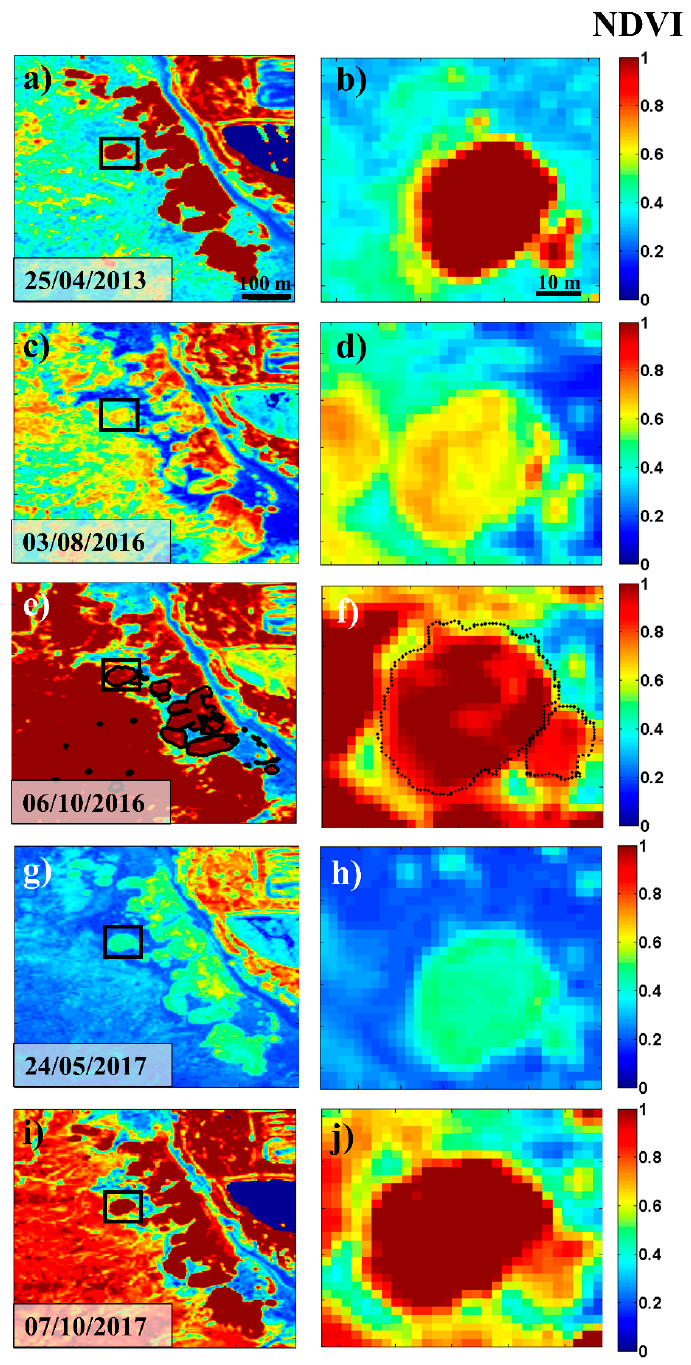
Figure 6. Comparison of the NDVI computed from the Pléiades images for the five considered dates, ( a , b ) 25 April 2013, ( c , d ) 3 August 2016, ( e , f ) 6 October 2016, ( g , h ) 24 May 2017, and ( I , j ) 7 October 2017. For each date, the image zooms in on the well-identified, small and invasive Spartina anglica and large native maritima meadows (right panel—see legend in Figure 5). Black contours on the image acquired on 6 October 2016 correspond to the field ground truth GNSS vegetation contours.